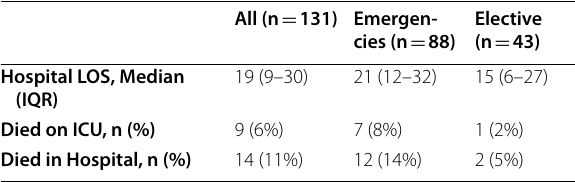
Table 2: Physiological Derangement/Organ